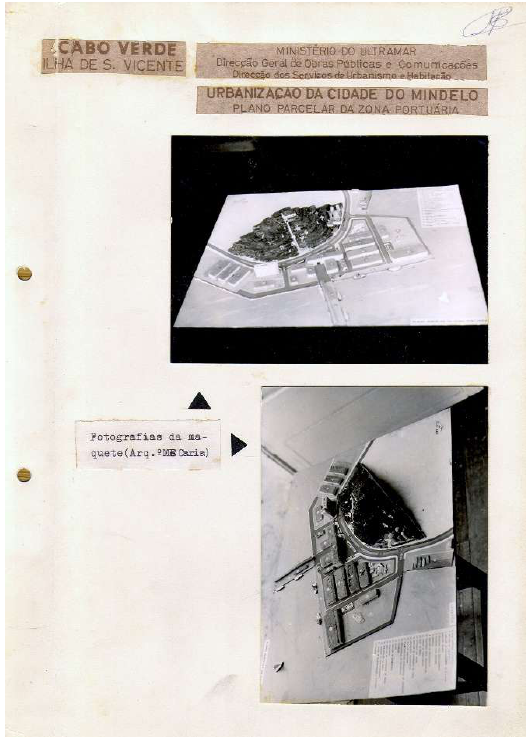
Figure 5. Maria Emília Caria. Mindelo seaport: model, c. 1969. “Urban Development Plan for Mindelo, São Vicente island, Cape Verde, Harbour area Plan”, 1969, Town Planning and Housing, General Council for Public Works and Communications, Lisbon, Ministry of Overseas Affairs, AHU: PT/IPAD/MU/DGOPC/DSUH/2060/07814. (Credits: Portugal, Overseas Historical Archive—PT-AHU, used with permission).